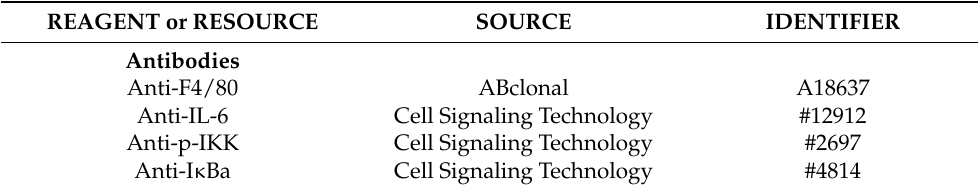
Table 1. The resource of Reagents and